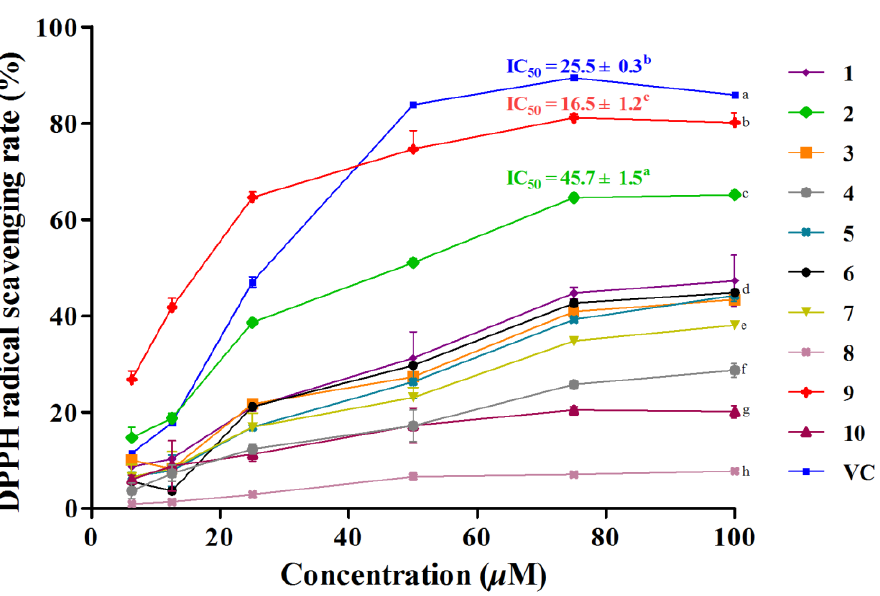
Figure 4. Radical scavenging activities of compounds 1 − 10 by DPPH assays. Vitamin C (VC) was used as positive control. Data are expressed as means ± SD ( n = 3). IC 50 values labeled by different letters (a–c) and the DPPH radical scavenging rate at 100 µ M labeled by different letters (a–h) were significantly different at a level of p < 0.05 ( n = 3) by one-way ANOVA DMRT.